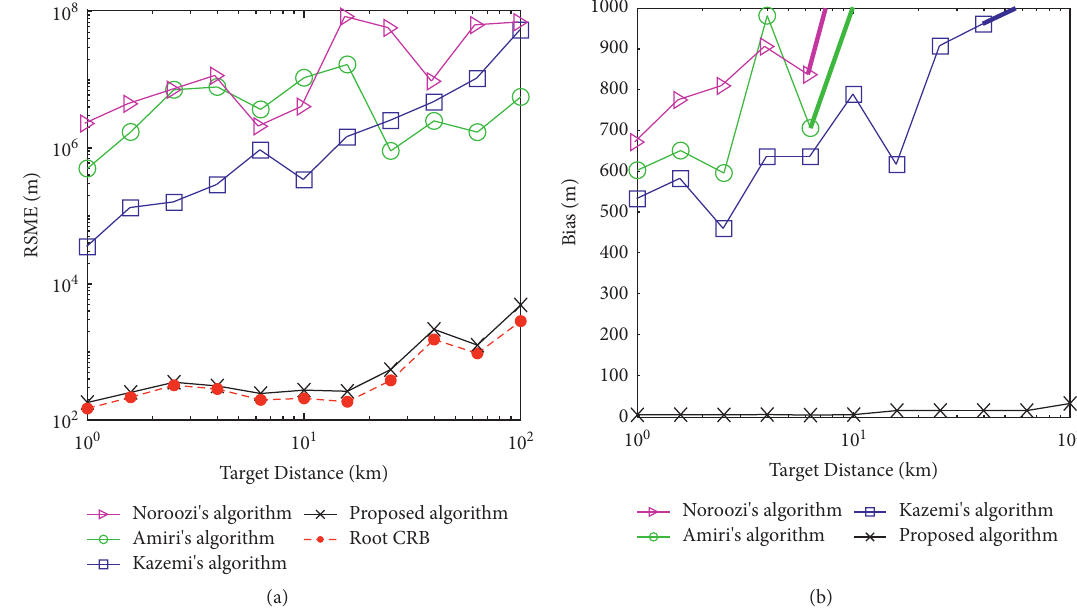
Figure 5: Localization (a) RMSE and (b) bias versus target distance for different algorithms.